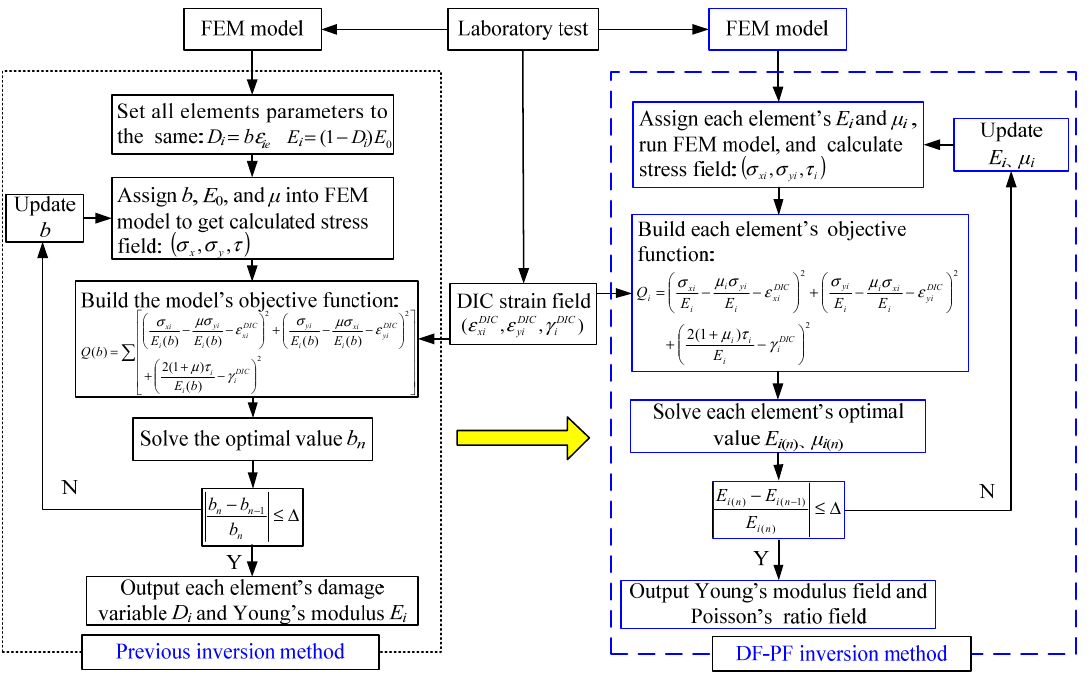
Figure 1. Flow charts of the DF-PF inversion method.